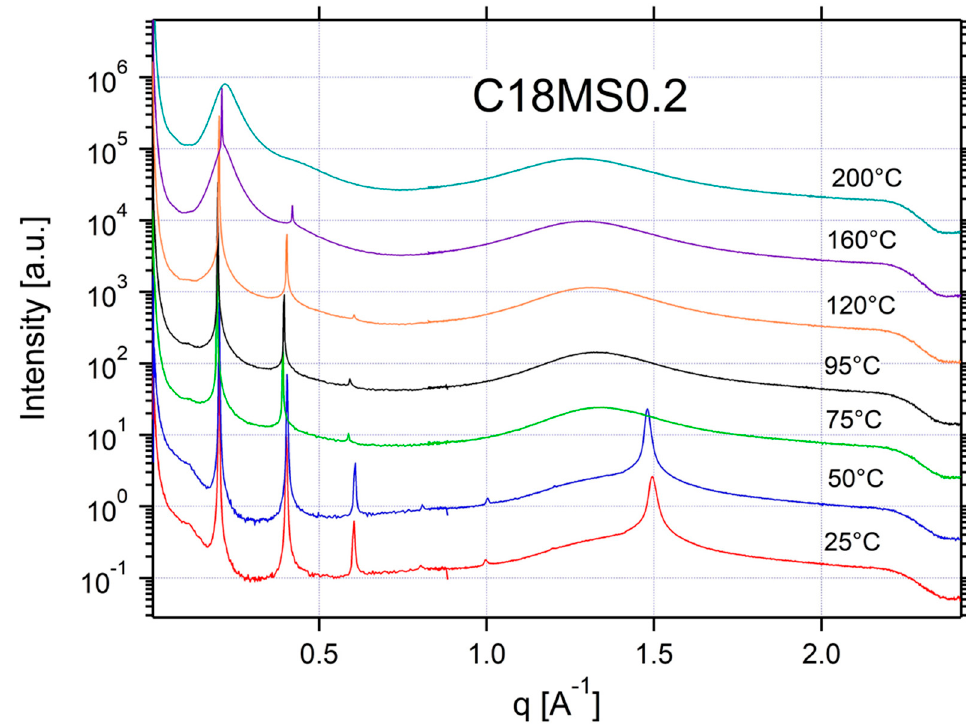
Figure A13. SAXS and WAXS data for 0.2:1 C18MS:C18LiTFSI.